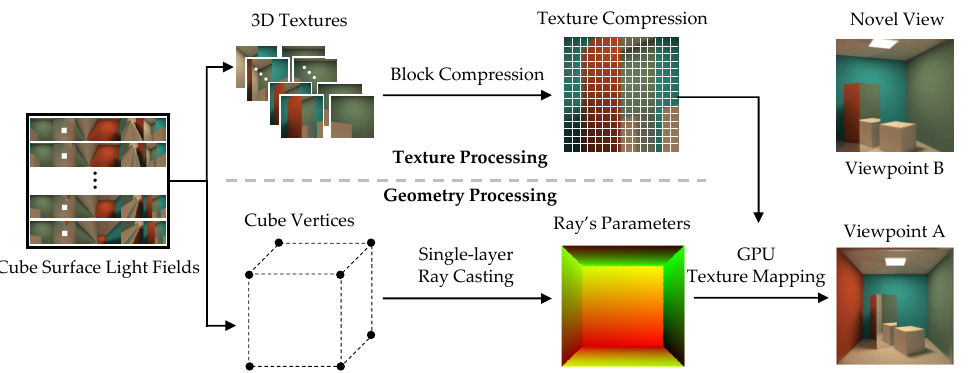
Figure 1. Overview of our interactive free-viewpoint rendering method using the cube surface light field scene